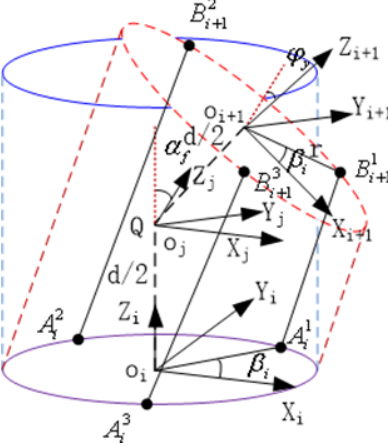
Figure 4. Analysis of the joint model’s coordinate